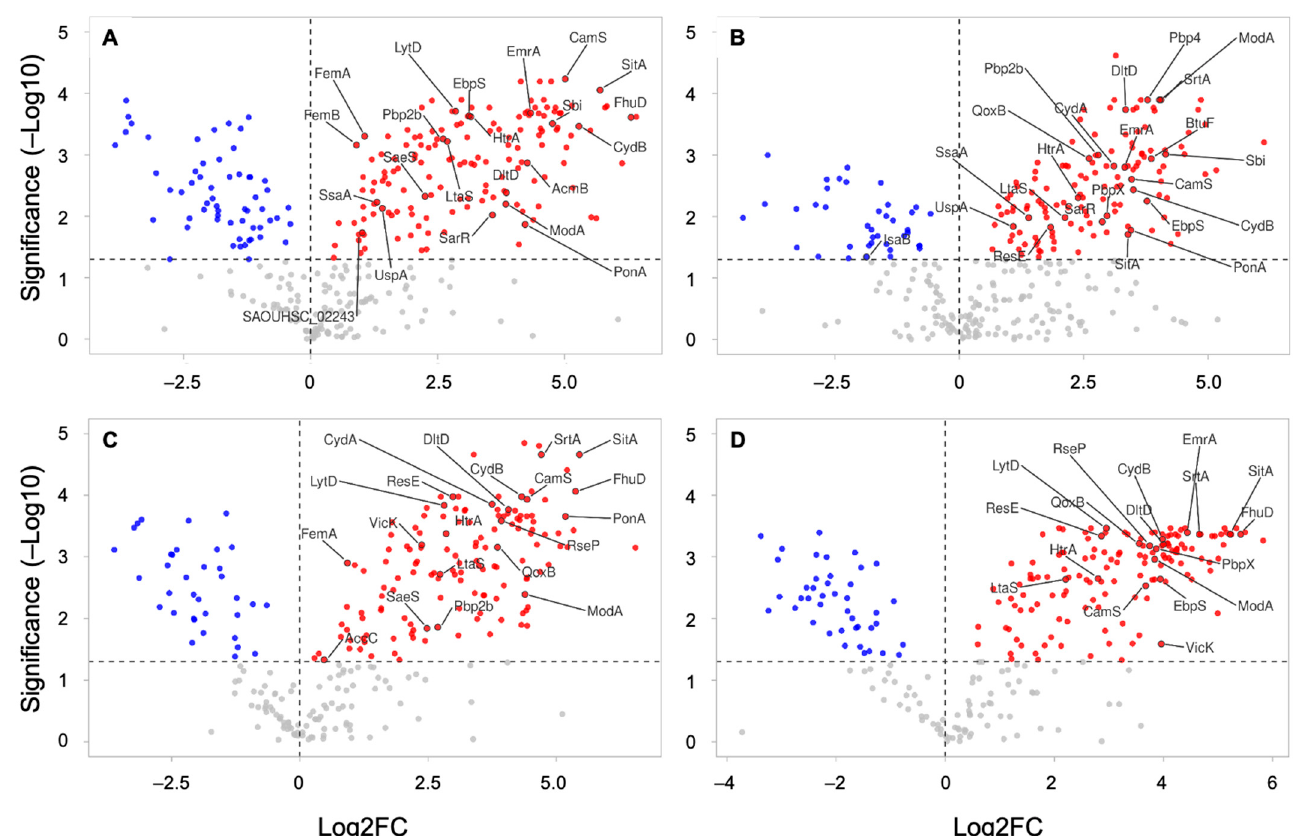
Figure 6. Volcano plots showing the relative protein abundance between S. aureus WC and its derived EVs. The graphs provide protein log2 fold change (log2FC) ratios between EVs and WC (EV/WC) conditions at 6 h without vancomycin (6V − ) ( A ), 6 h with vancomycin (6V+) ( B ), 12 h without vancomycin (12V − ) ( C ), and 12 h with vancomycin (12V+) ( D ). The vertical and horizontal dotted lines show the log2FC and significance threshold (adjusted p -value < 0.05), respectively. The results are plotted on a logarithmic scale, with negative log2FC in blue, positive log2FC in red, and nonsignificant values in grey.